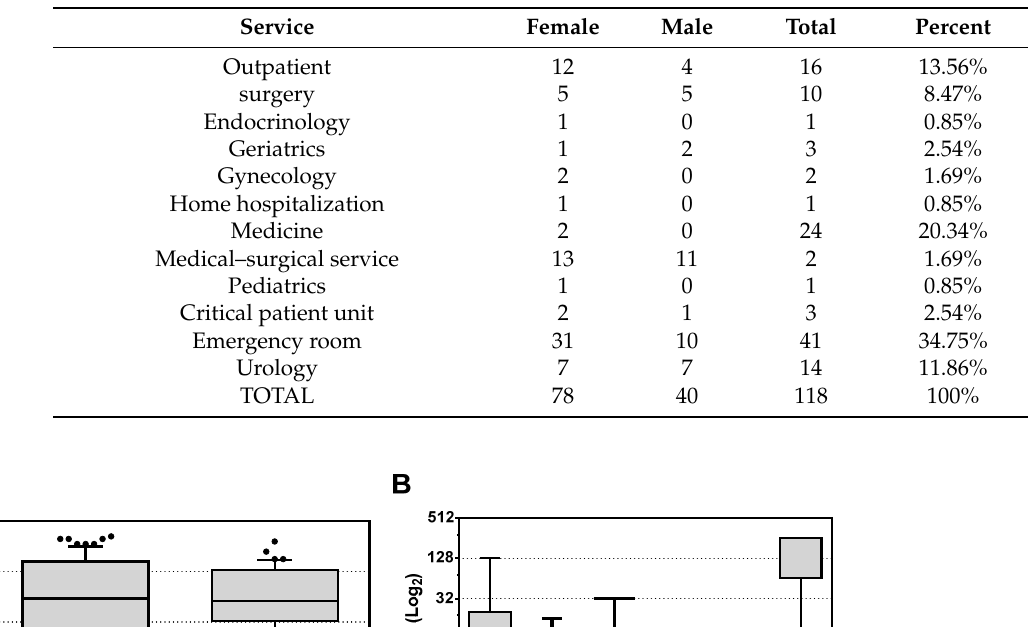
Table 2. Frequency of K. pneumoniae isolation by hospital unit and genre.